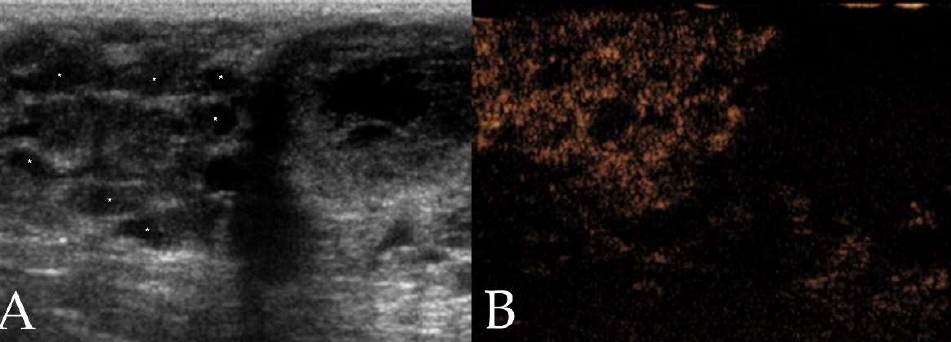
Figure 2. Ultrasonographic images of a mammary adenocarcinoma in a 10 year old intact Labrador Retriever. ( A ) On B-mode ultrasonography, the neoplasm shows a multilobulated shape, ill-defined border, mixed echogenicity, and heterogeneous echotexture with presence of cystic areas (stars). ( B ) Contrast-enhanced ultrasonography (CEUS) shows heterogeneous enhancement.